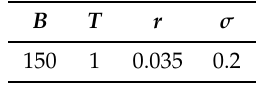
Table 1. Floating strike up-and-out call option data.